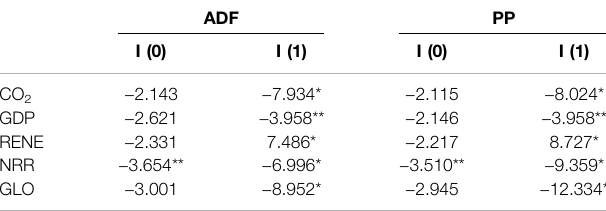
TABLE 3 | Conventional unit-root outcomes.